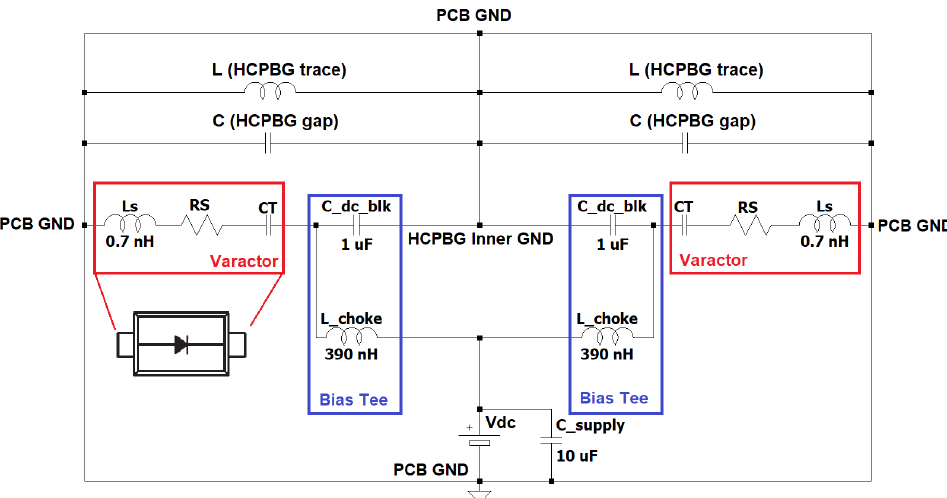
Figure 13. Reconfigurable HCPBG—varactor and bias tee schematic. The discrete component values used in the simulation can be seen in Table